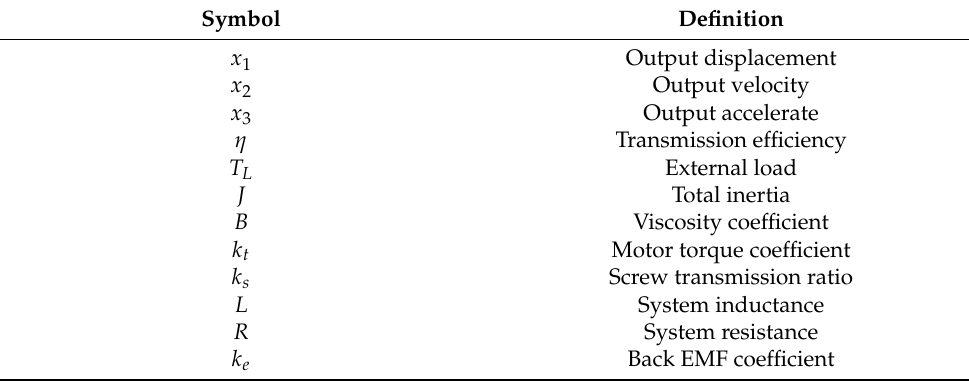
Table 1. Notations used for ADRRAC system.